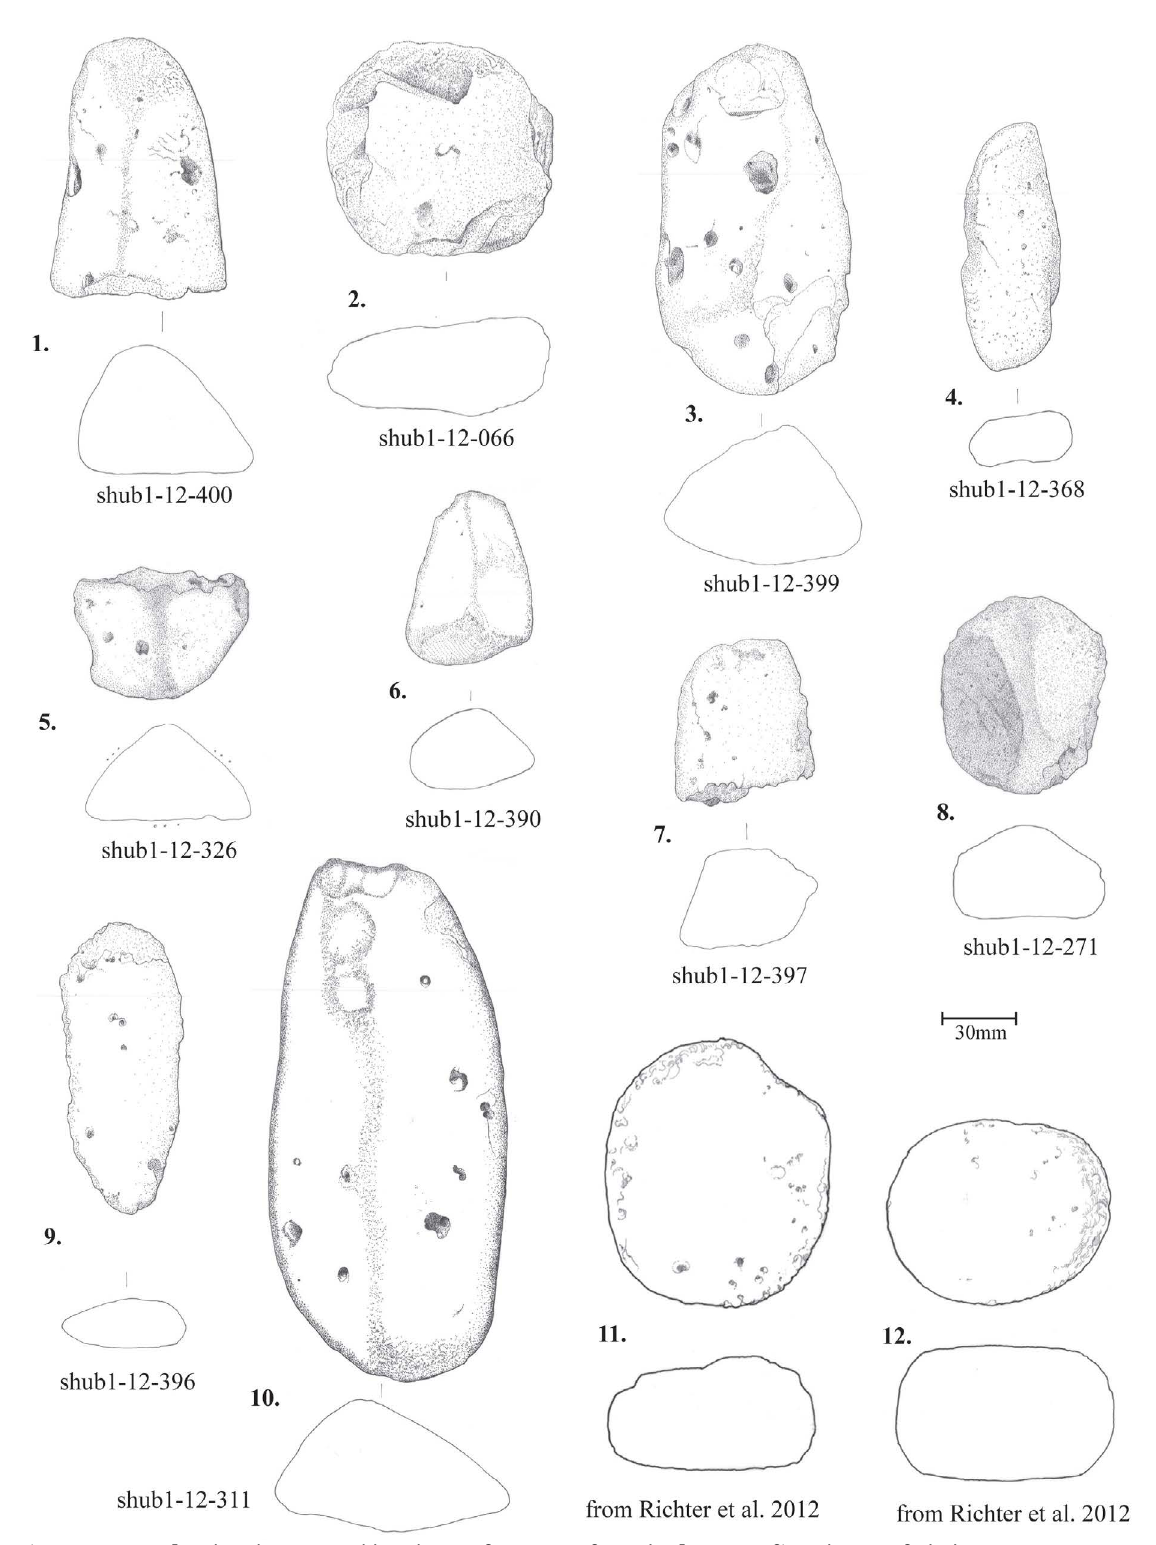
Figure 6: Complete handstones and handstone fragments from the late Natufian phases of Shubayqa